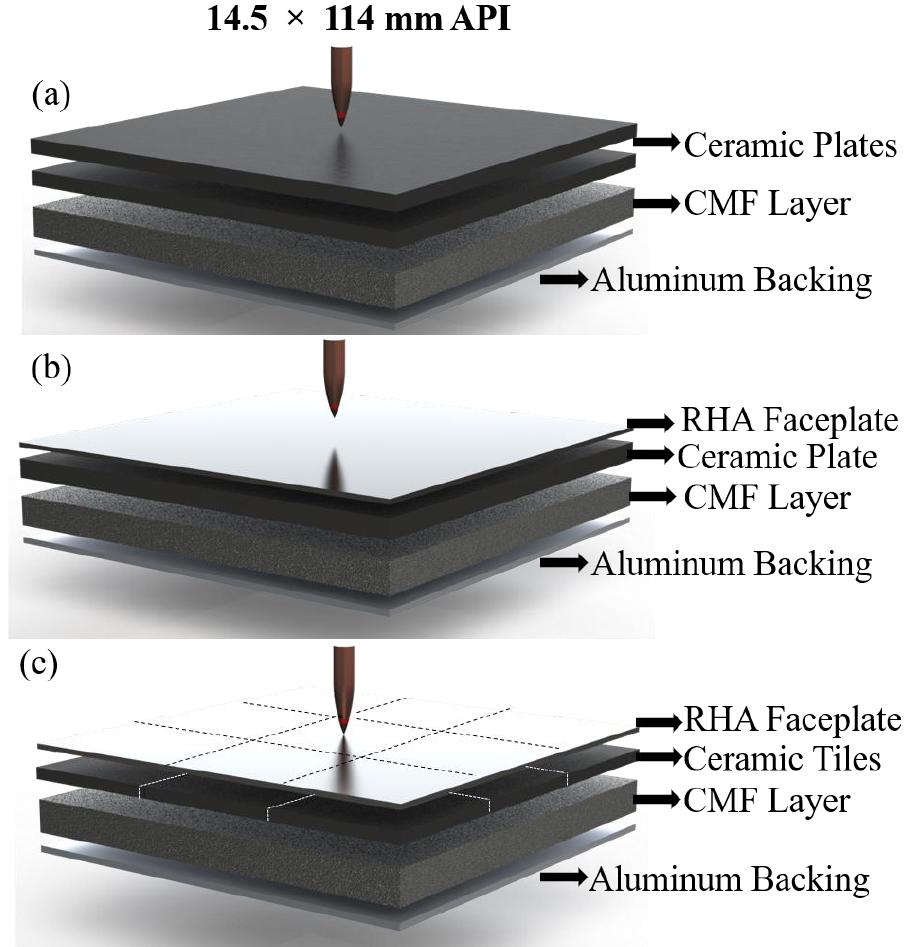
Figure 3. Exploded view diagram showing the arrangement of the CMF armors using ( a ) a two-layer ceramic face sheet, ( b ) a thin rolled homogeneous armor (RHA) faceplate above one ceramic layer, and ( c ) RHA above a layer of individual ceramic tiles. Note that the thicknesses and sizing are not to